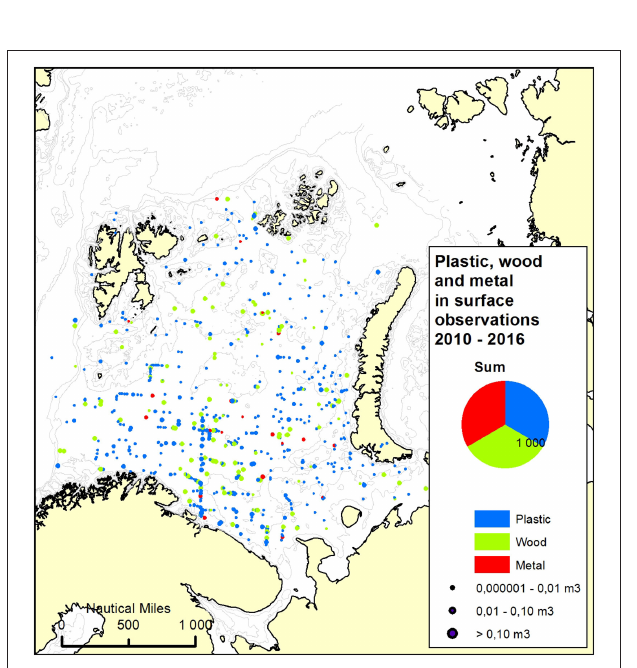
FIGURE 4 | Marine litter from pelagic trawl from 2010 to 2016. Observations of plastics (blue), paper (purple) and textile (red).